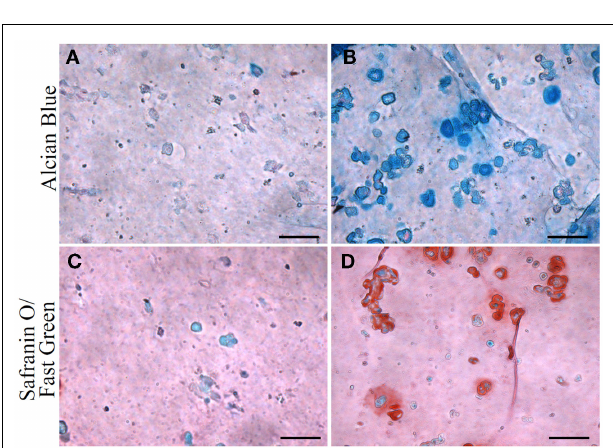
FIGURE 7 | Glycosaminoglycan (GAG) and proteoglycan content in hASC-encapsulated VL-PSL-fabricated constructs visualized by Alcian blue and safranin O/fast green staining at day 28 . (A,C) Alcian blue and safranin O staining, respectively, of control group. Negligible amounts of GAG and proteoglycan are detected. (B,D) Alcian blue and safranin O staining, respectively, of TGF- β 3 group at day 28, showing strong staining. Scale bar: 50 μ m.